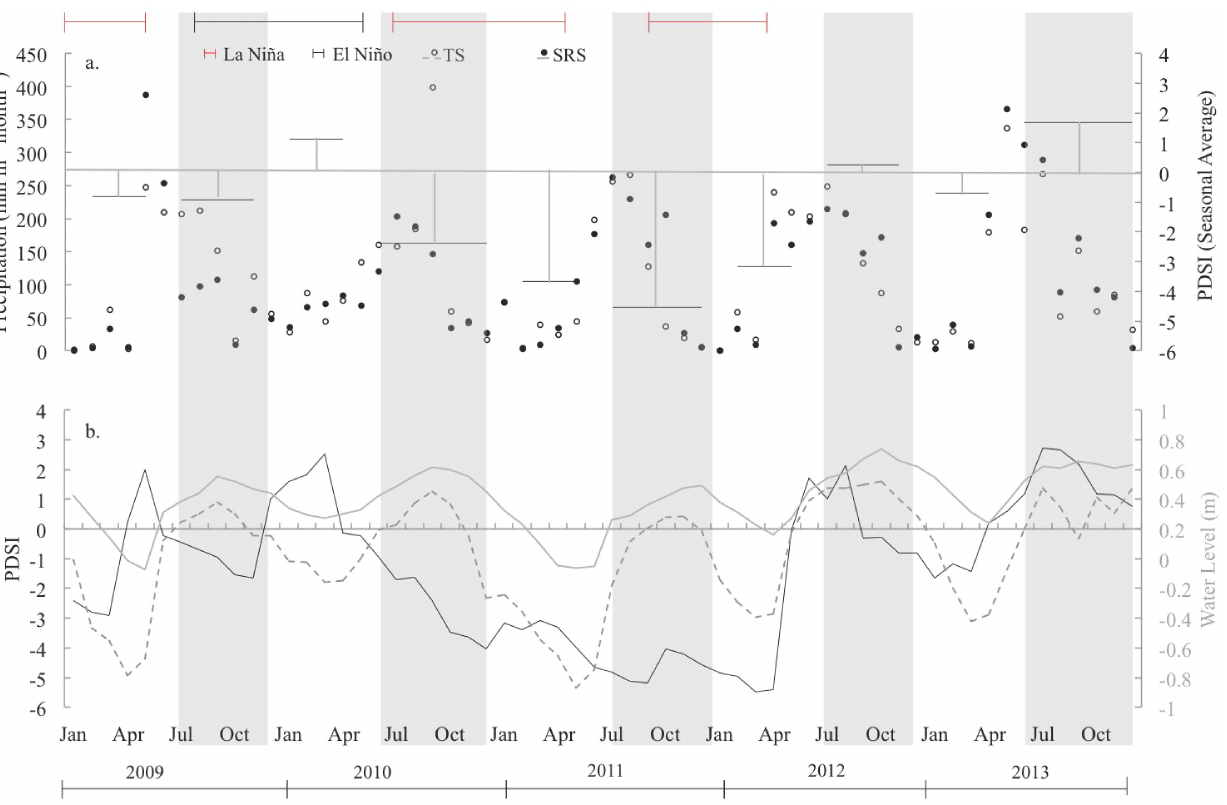
Fig. 3. Time series of precipitation, PDSI, and water levels at TS and SRS. (a) Shows monthly cumulative precipitation (mm) and season intensity (as measured by seasonal average PDSI), (b) shows monthly average Palmer Drought Severity Index (PDSI), water level (m), and El Nin˜o and La Nin˜a